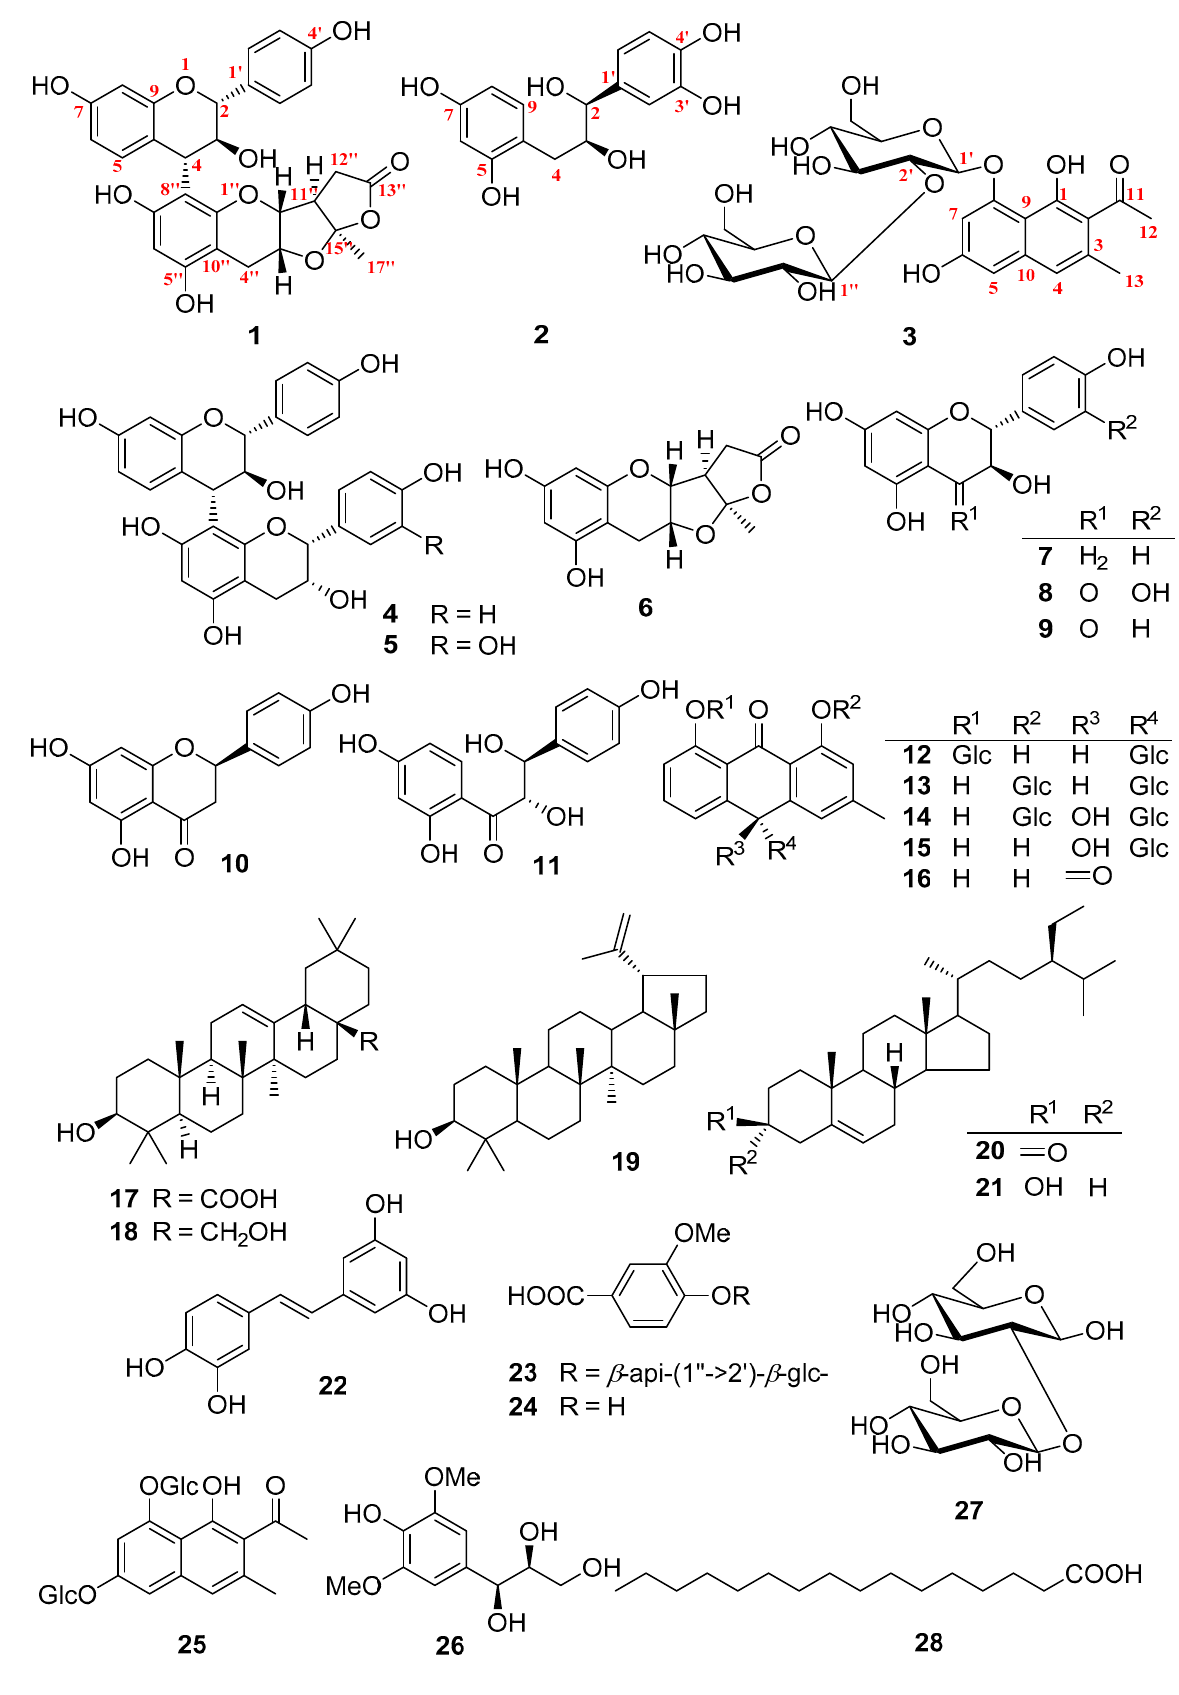
Figure 1. Compounds 1 – 28 from Cassia abbreviata.